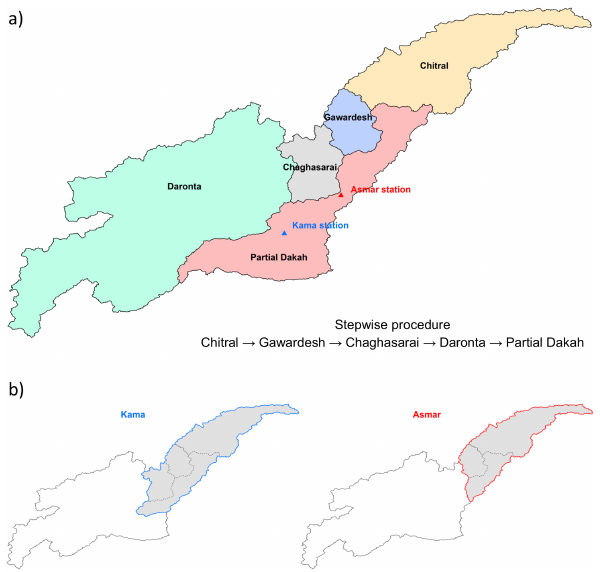
Figure 5. (a) Sub-basins corresponding to five gaging stations are used for the multisite calibrations. (b) Two sub-basins (Kama and Asmar) are assumed to be ungaged and used for evaluating the cal- ibration